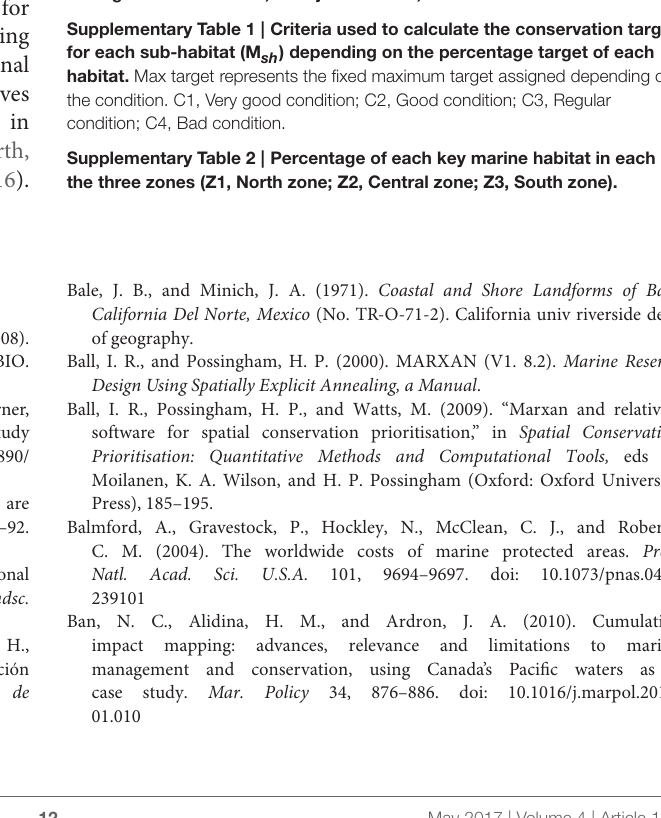
Supplementary Table 1 | Criteria used to calculate the conservation target for each sub-habitat (M sh ) depending on the percentage target of each habitat. Max target represents the fixed maximum target assigned depending on the condition. C1, Very good condition; C2, Good condition; C3, Regular condition; C4, Bad